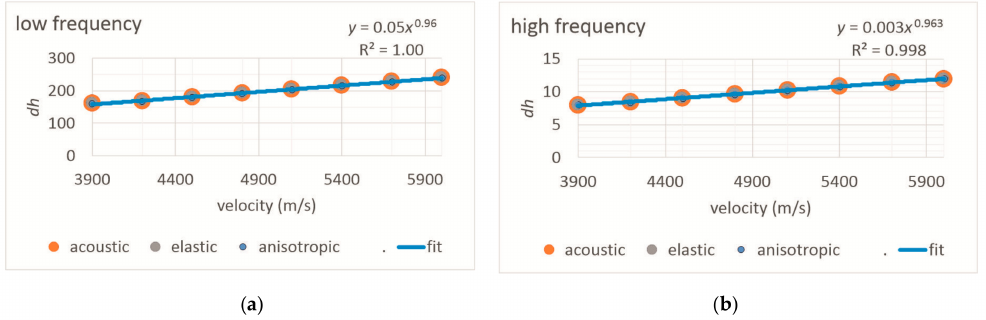
Figure 10. The relationships between the distance to the nearest calculation nodes dh (the largest allowable spatial modeling step) and velocity of the slowest wave for: low ( a ) and high ( b ) frequencies of the source